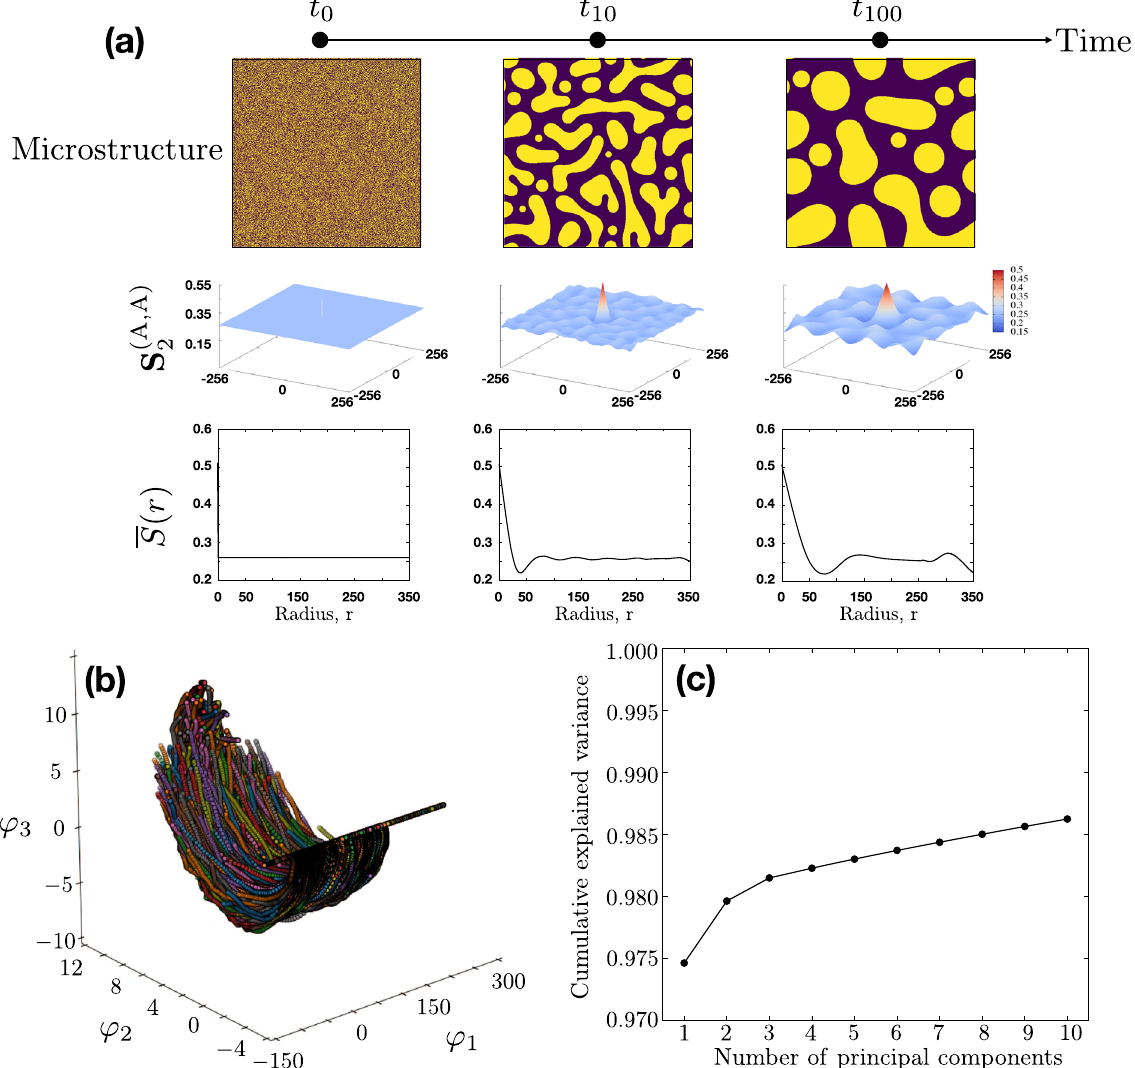
Fig. 2 Low-dimensional representation of the microstructure evolution. a Transformation of a two-phase microstructure realization (top row) to its autocorrelation representation (middle row: autocorrelation; bottom row: radial average) at three separate frames ( t 0 , t 10 , and t 100 ). b Microstructure evolution trajectories over 100 frames represented as a function of the fi rst three principal components. c Cumulative variance explained as a function of the number of principal components included in the representation of the